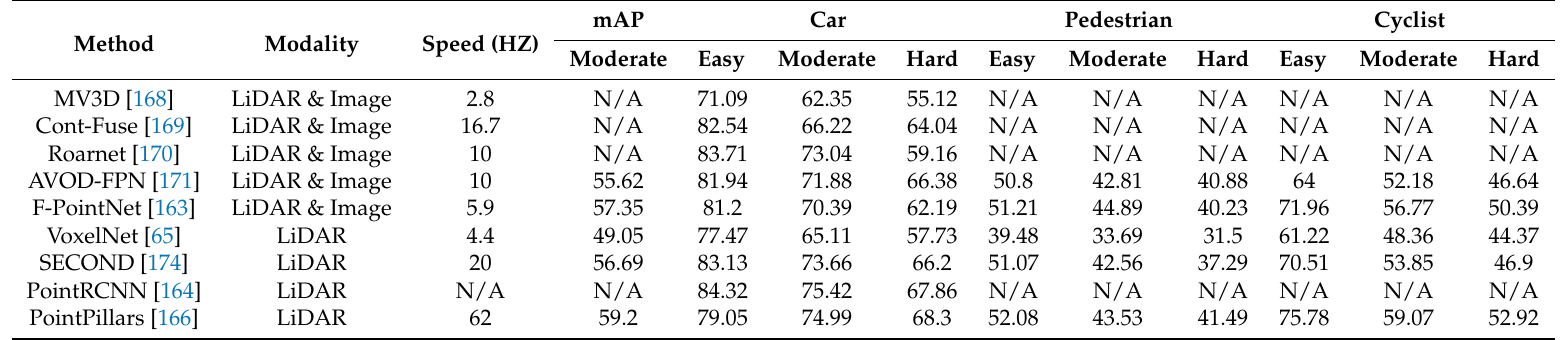
Table 8. Performance on the KITTI 3D object detection